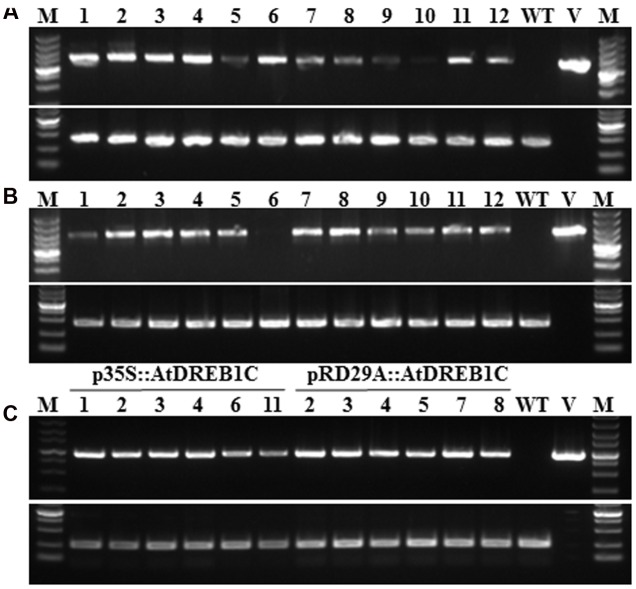
Identification of transgenic AtDREB1C Salvia miltiorrhiza plants via PCR. (A) PCR analysis of primary transformants using specific primers for 35S::AtDREB1C. Lanes 1 and 16, size markers; lanes 2–13, DNA from putative transformants; lane 14, untransformed control; lane 15, p35S::AtDREB1C. The 18S rRNA gene was used as a control. (B) PCR analysis of primary transformants using specific primers for RD29A::AtDREB1C. Lanes 1 and 16, size marker; lanes 2–13, DNA from putative transformants; lane 14, untransformed control; lane 15, pRD29A::AtDREB1C. The 18S rRNA gene was used as a control. (C) RT-PCR analysis of AtDREB1C expression in transgenic plants using under drought conditions. Lanes 1 and 16, size markers; lanes 2–7, DNA from PCR-positive p35S::AtDREB1C transformants; lanes 8–13, DNA from PCR-positive pRD29A::AtDREB1C transformants; lane 14, untransformed control; lane 15, p35S::AtDREB1C and pRD29A::AtDREB1C. The actin gene served as the internal control.